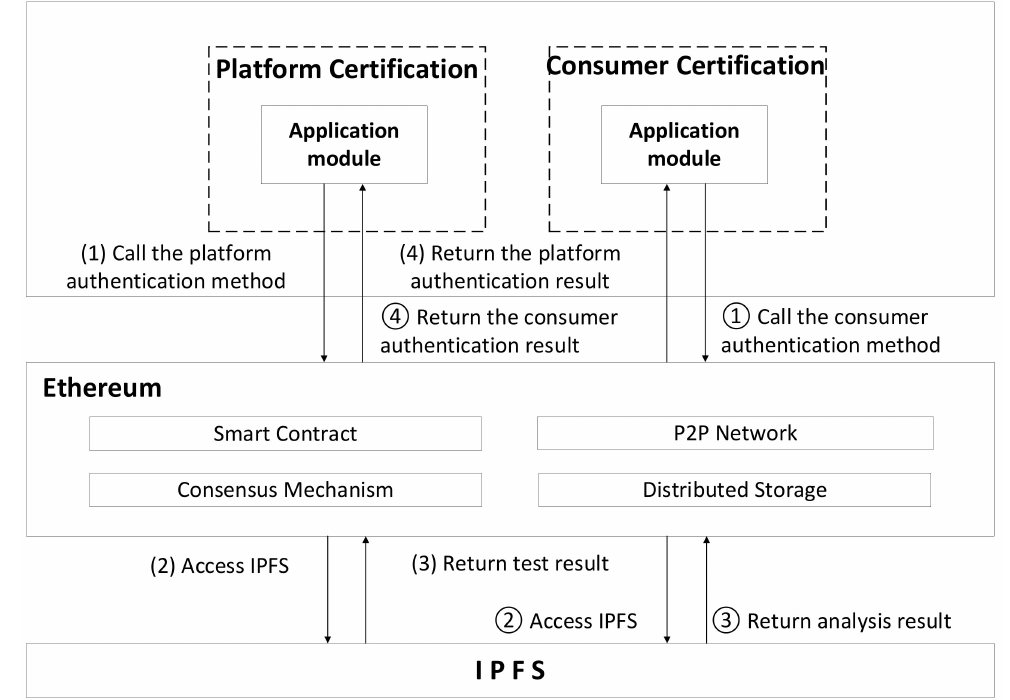
Figure 5. Product traceability certification architecture